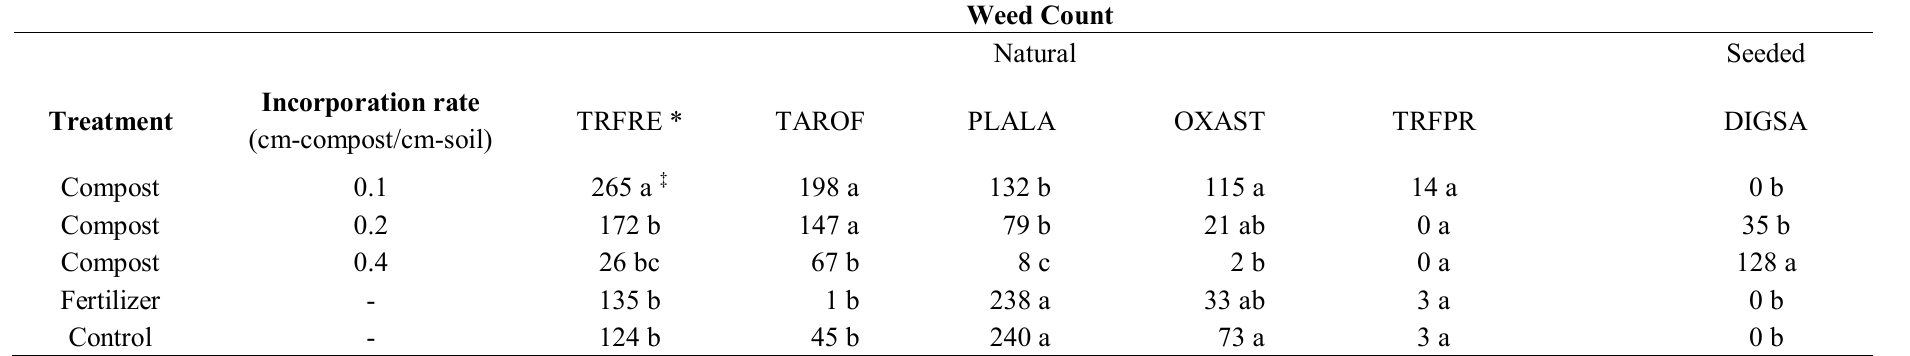
Table 2. Number of naturally occurring weeds and manually seeded large crabgrass seeds in seeded turf plots. Weed Count Natural Seeded